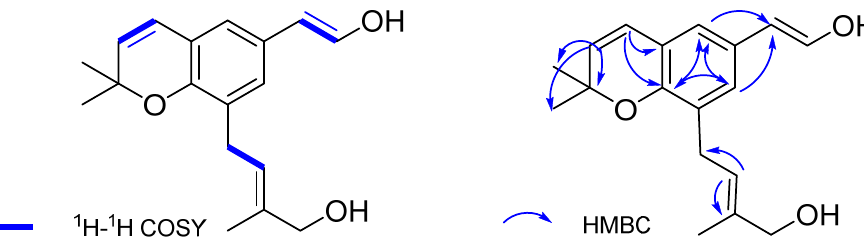
Figure 6. 1 H- 1 H COSY and key HMBC correlations (H → C) of compound 1 ’. The 1 H- 1 H COSY correlations revealed the relations between H-2 to H-3, H-10 to H-11 and H-12 to H-13 (Figure 6). A comparison of compound 1 ’ with the known